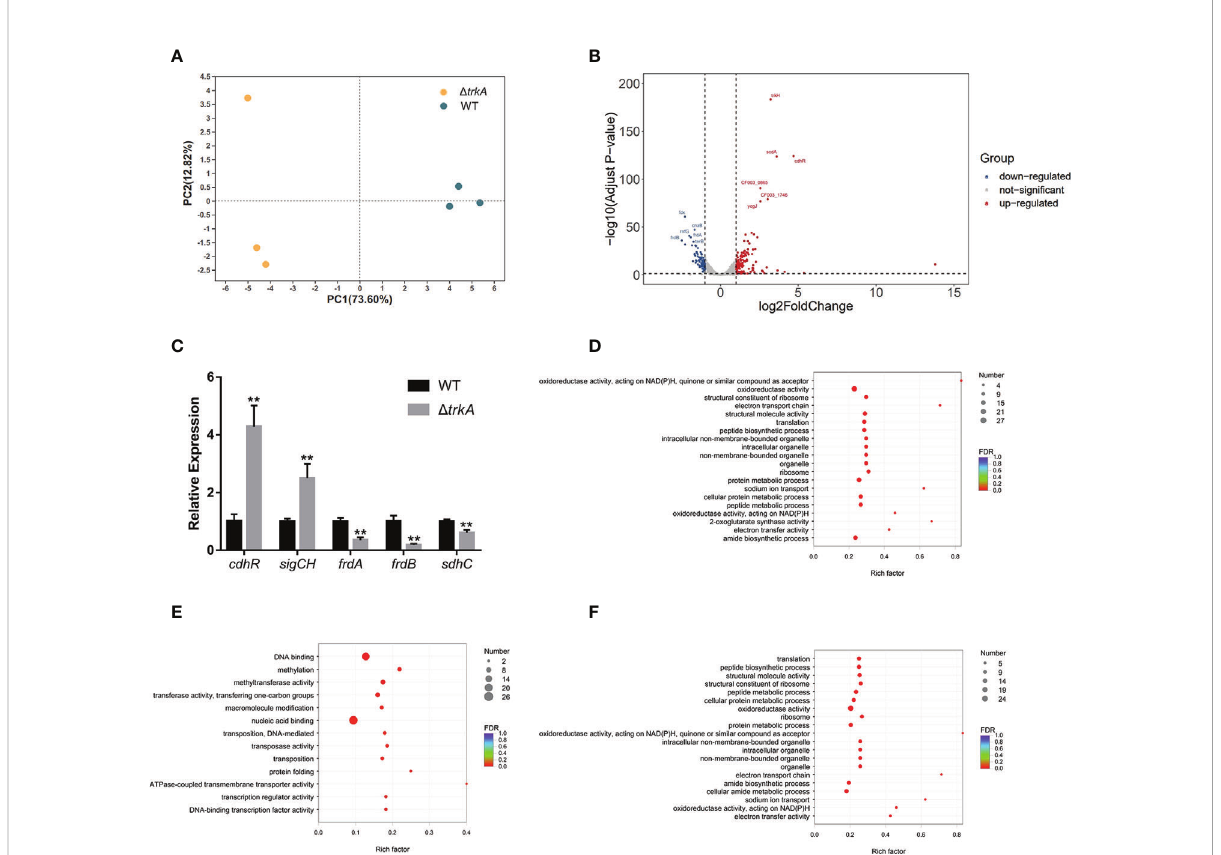
FIGURE 1 Transcriptional pro fi ling of Porphyromonas gingivalis D trkA versus the wild-type (WT) strain. (A) Principal component analysis of P. gingivalis D trkA versus the WT strain shows a clear divergence. (B) Volcano plot of differentially expressed genes. (C) qRT-PCR analysis of a subset of differentially expressed genes detected by RNA sequencing. Gene ontology enrichment analysis of (D) differentially expressed genes, (E) upregulated genes, and (F) downregulated genes in the P. gingivalis D trkA strain. Data are presented as means ± SD, normalized to 16S rRNA and compared to WT (2 − DD CT ). N = 3, ** p <